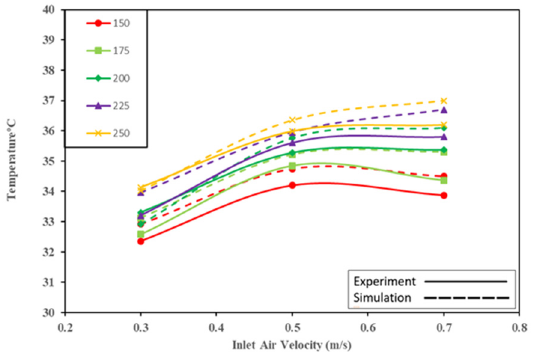
Figure 10. Outlet water temperature comparison for experimental and numerical analysis with different input air velocities and